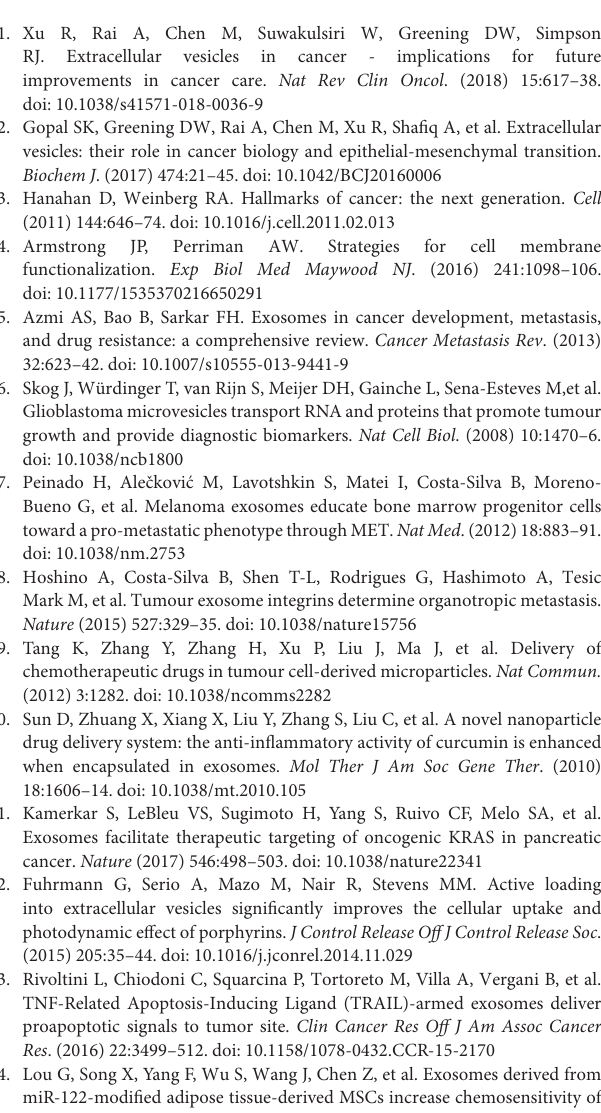
cytometry using Absolute Counting Beads. Bar graphs present the mean ± SD calculated for three repeats. The differences between the groups were estimated using the nonparametric Kruskal-Wallis test followed by Dunn’s multiple comparison test ( ∗ p < 0.05, ∗∗∗ p < 0.001). Supplementary Figure 2 | Flow cytometry analysis of TEx and TMv isolated from wild-type or genetically modified MC38 cell lines. Histograms represent the expression of CD63, CD9, CD81 on the surface of TEx and TMv. Bar graphs present the mean ± SD calculated for three repeats. The differences between the groups were estimated using the nonparametric Kruskal-Wallis test followed by Dunn’s multiple comparison test ( ∗ p < 0.05). Supplementary Figure 3 | Concentration of IFN- γ in supernatants from spleen cells stimulated with TEx or TMv, isolated from wild-type or genetically modified MC38 cell lines. Bar graphs present the mean ± SD calculated for three repeats. The differences between the groups were estimated using the nonparametric Kruskal-Wallis test followed by Dunn’s multiple comparison test ( ∗ p < 0.05, ∗∗∗∗ p <